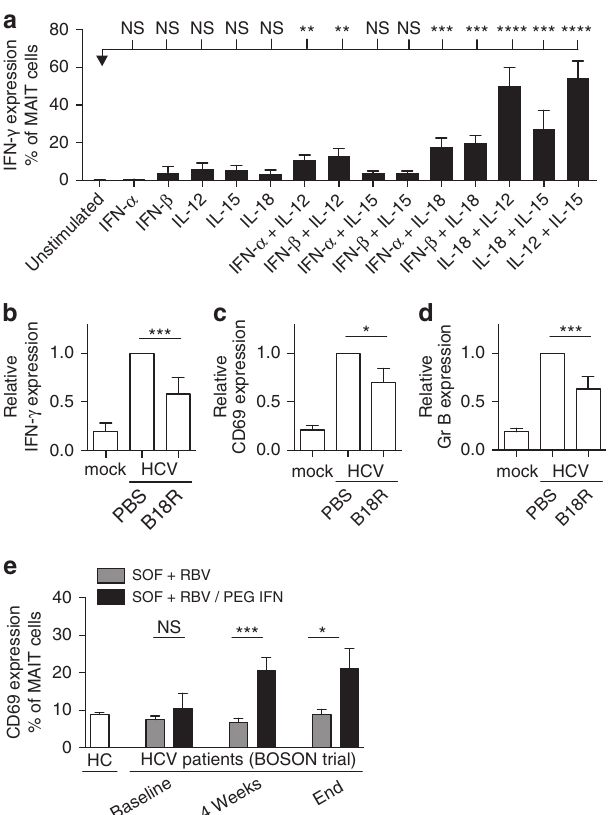
Figure 6 | MAIT cells respond to type I interferons in vitro and in vivo . ( a ) PBMC’s from healthy individuals were directly stimulated for 24h with IFN- a , IFN- b , IL-12, IL-15, IL-18 or indicated combinations thereof. IFN- g expression by MAIT cells (gated on live CD3 þ CD8 þ CD161 þ þ V a 7.2 þ cells) was analysed by flow cytometry. ( b – d ) B18R (IFN- a / b neutralizing protein) or PBS control were added to the co-culture ( n ¼ 6–11). IFN- g ( b ), CD69 ( c ) and Granzyme B ( d ) expression is shown relative to the control. Data are representative from at least two independent experiments. ( e ) PBMC’s from healthy controls or HCV patients at baseline, during or end of treatment with either SOF þ RBV or SOF þ RBV/PEG-IFN were analysed by flow cytometry. CD69 expression on MAITcells (gated on live CD3 þ CD8 þ CD161 þ þ V a 7.2 þ cells) was measured. Bars represent means ± s.e.m. Statistical significance was determined with the Kruskal–Wallis test followed by the Dunns’ test ( a ) or the Mann–Whitney test ( b – e ). ns 4 0.05, * P 0.05, *** P r 0.001, **** P r 0.0001. HC, healthy controls. (PEG-IFN), or only SOF þ RBV, without PEG-IFN. Interestingly, CD69 expression on MAIT cells was upregulated only in the treatment group receiving PEG-IFN (Fig. 6e), which corresponded with a significantly higher sustained virologic response rate 36 . High CD69 upregulation was specific to CD161 þþ MAIT cells and not observed on CD161 (cid:2) CD8 þ or CD4 þ T cells (Supplementary Fig. 9). These data demonstrate that type I IFNs can contribute to MAIT cell activation in vitro and in vivo. activation by measurement of IFN- g secretion (Fig. 7a). The cell NATURE COMMUNICATIONS|7:11653|DOI: